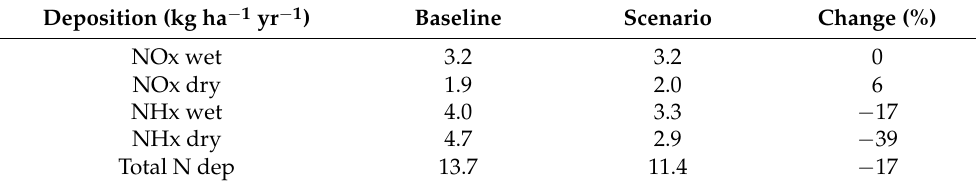
Table 4. The modeled annual depositions of NOx and NHx (wet and dry) into the Limfjord catch- ment area and to the marine areas of the Limfjord in the two simulations. The total deposition and Table 5. Percentage areas on which critical loads are exceeded in the baseline and the change between the baseline and the scenario are also given.